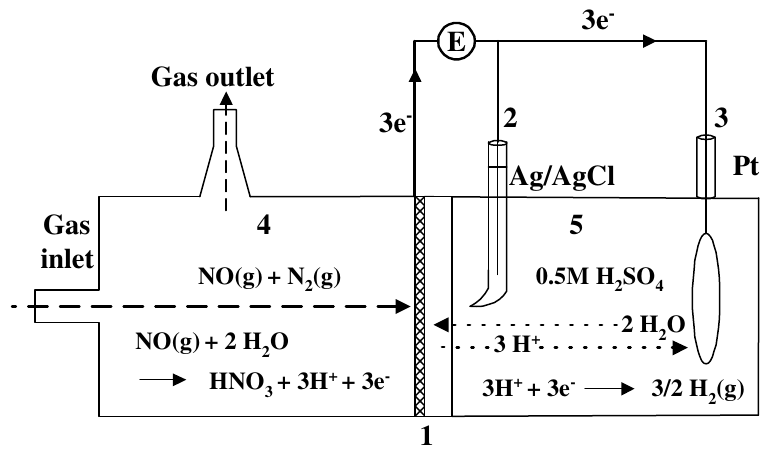
Figure 1 . An experimental setup for the electrochemical oxidation of NO at a Pt/Nafion ®